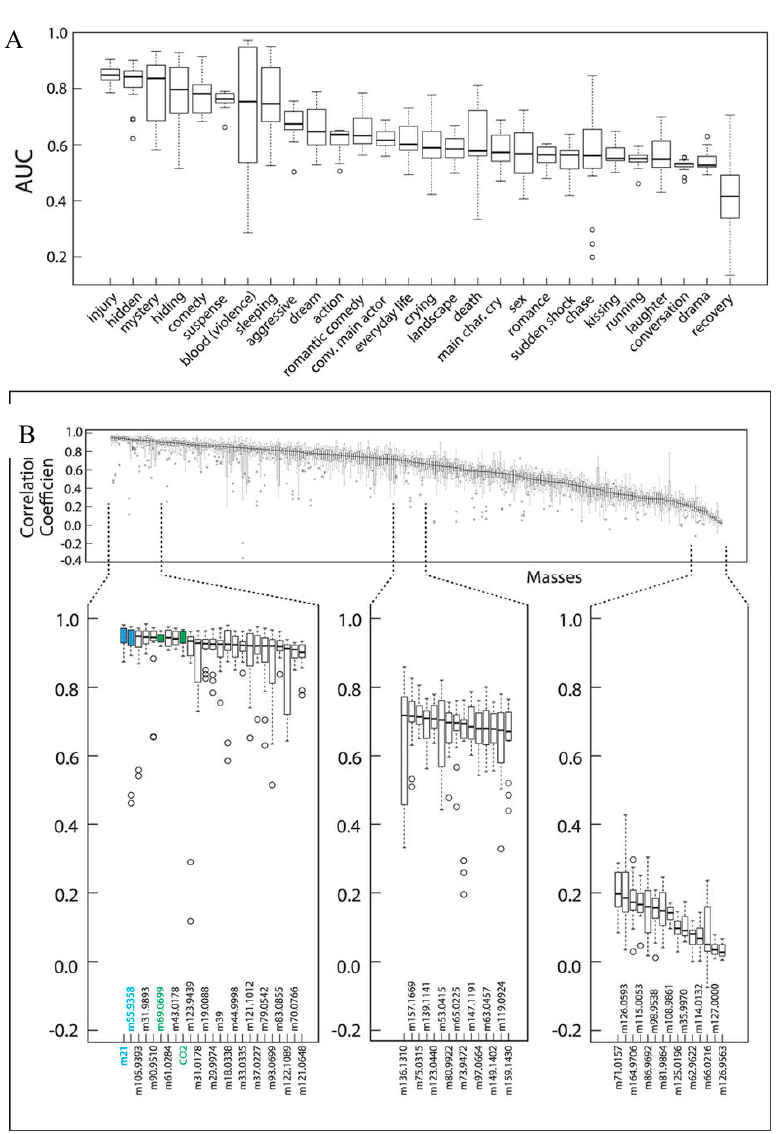
Figure 18. Shown are the results when two thirds of the whole film screening dataset is randomly selected (15 times) and the resultant model tested on the remaining third. The boxes indicate the extent of 25% of the data either side of the median (solid line). The dashed vertical line represents the lowest/highest datapoints that are still in the 1.5 interquartile range while the circles are outliers. ( A ) shows AUC which expresses the ratio between true positives (when the model correctly predicted labels based on mass decision trees) and false positives (backward prediction). A random prediction produces an AUC value of 0.5; ( B ) shows the ability of an individual mass to be predicted by the labels (forward prediction). The performance of this prediction versus the real value for VOC mixing ratios is given as the Pearson’s correlation coefficient (r). High correlation coefficients indicate the predictive model was successful for that particular species, and not that all species with high correlation coefficients are inter-correlated. Used with permission from [103].